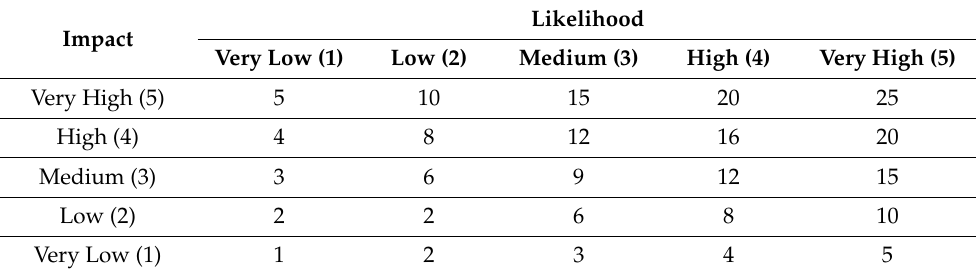
Table 9. Risk score matrix for qualitative